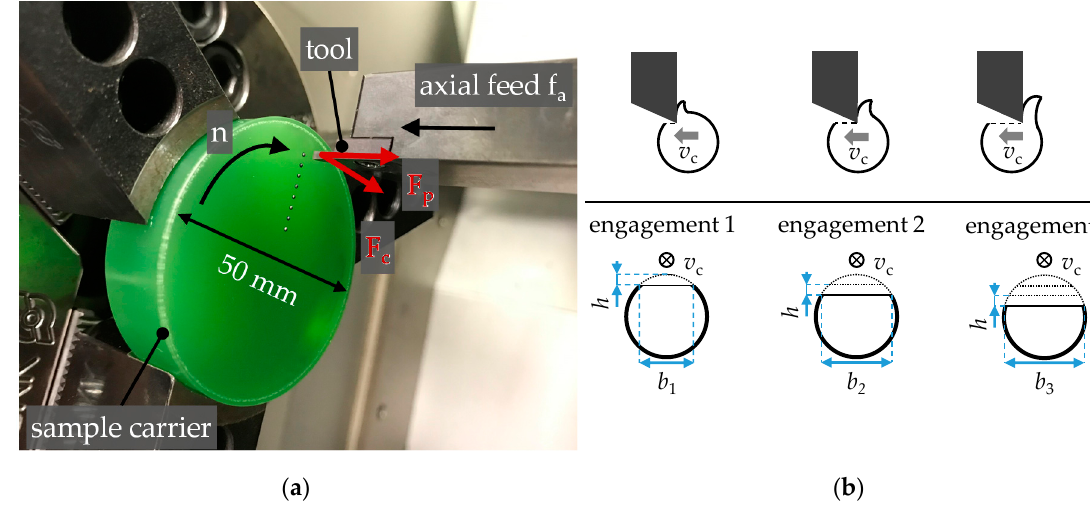
Figure 3. ( a ) Machining setup and ( b ) cutting conditions for axial feed turning of spherical micro-samples.